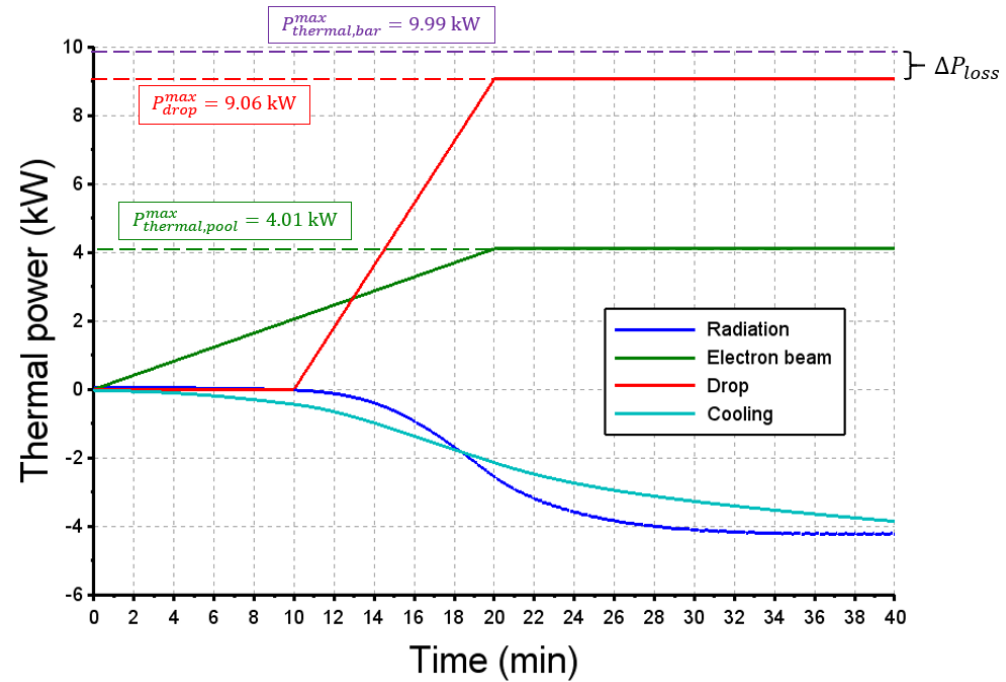
Figure 14. Assessment of the global heat balance of the charge with time. If positive, the heat power is received by the charge.